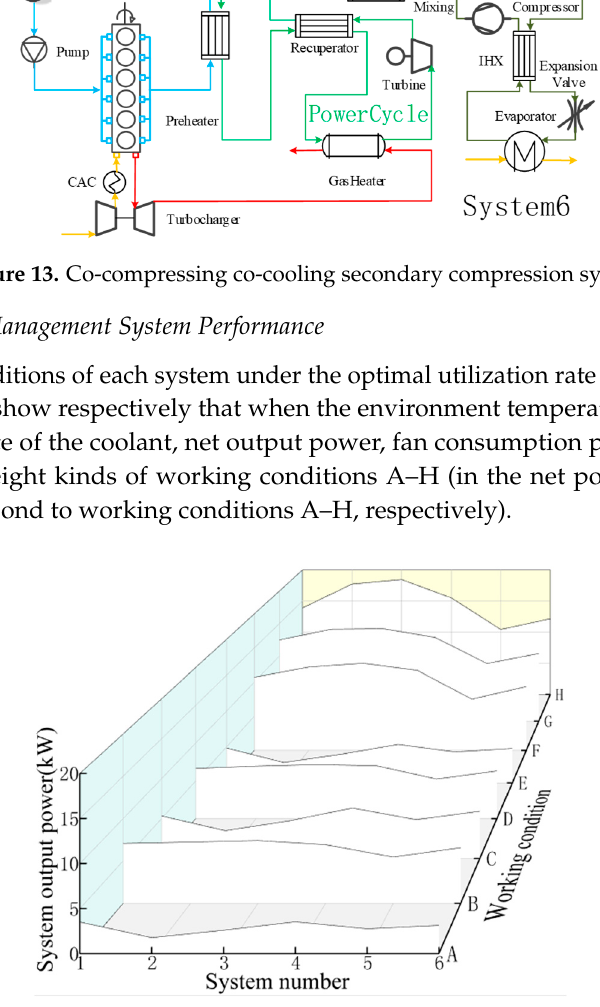
Figure 14. Under 15 °C net output power of each system under different working conditions.